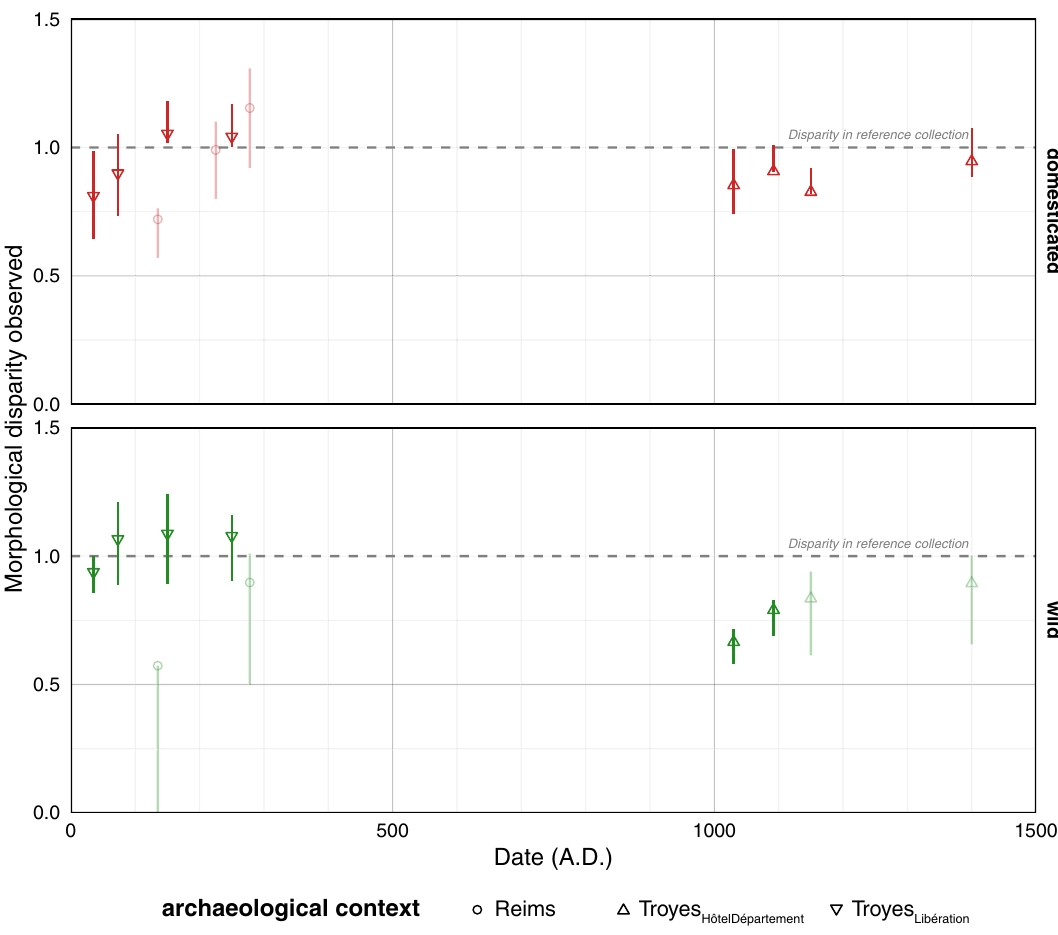
Figure 5. Dynamics of morphological disparity. For each compartment, disparities were standardized by the observed disparities in the reference collection. Symbols represent sites, confidence intervals were obtained through 10 3 permutations, colors report identification obtained with LDA status , all are faded when sample sizes are